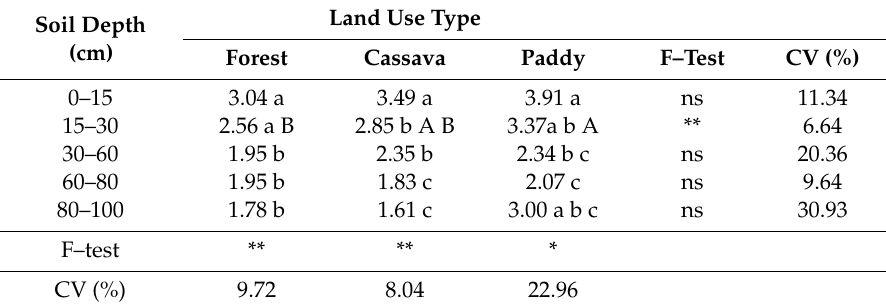
Table 2. Ratio of E4:E6 of humic acids in layers down the soil profile of various land uses. Soil Depth (cm)